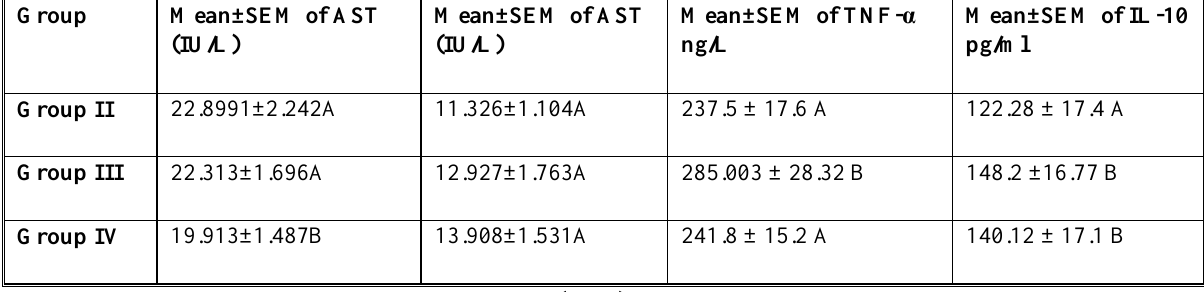
Table 3. Effect of co-administration of therapeutic dose of lornoxicam and omega 3 on the liver tissue enzymes (ALT and AST) and cytokines (TNF-α, IL-10) levels in male rats compared to omega 3 and lornoxicam-treated group.